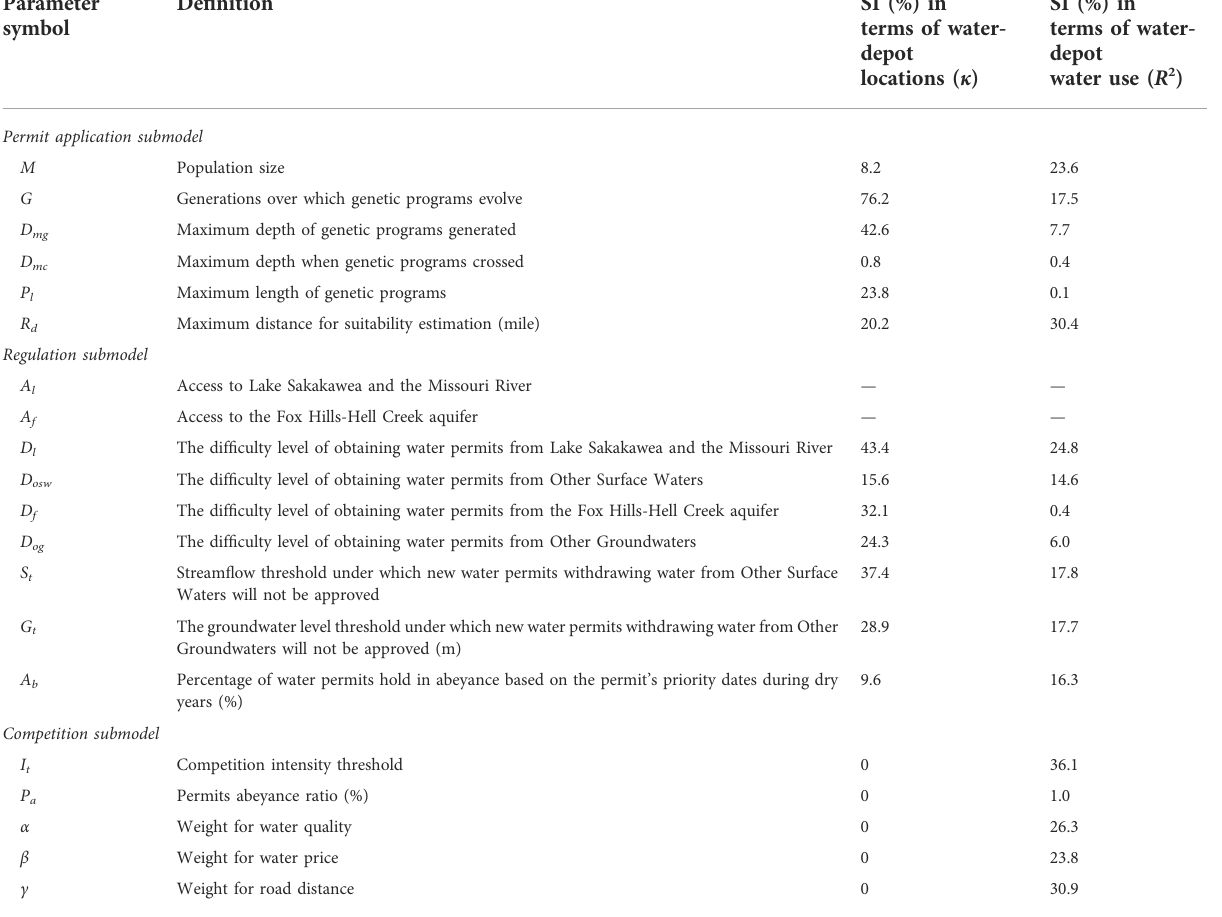
TABLE 5 Sensitivity Index (SI) values of the parameters in the three submodels of the agent-based